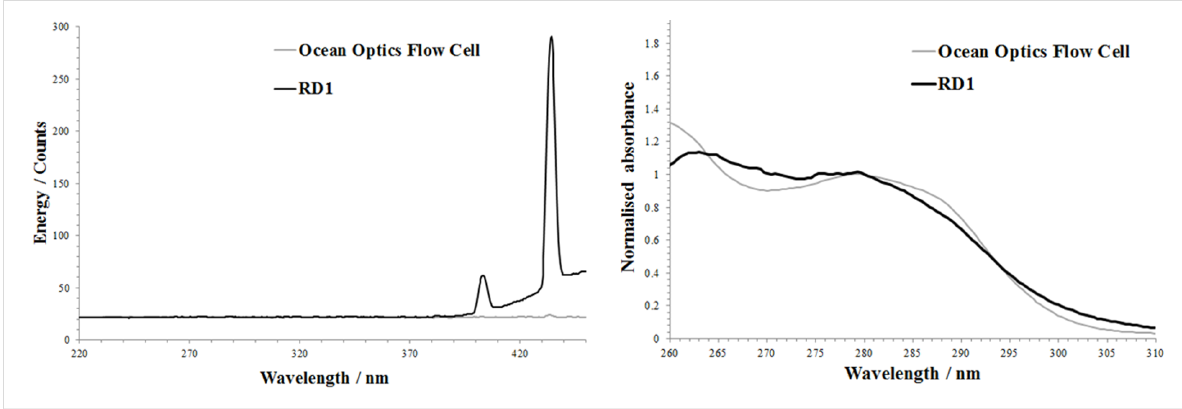
Figure 2: Energy versus wavelength spectra comparing the amount of stray light being picked up by the detector using both RD1 and a commercial flow cell (left), normalised absorption spectra of a benzaldehdye solution passing through both RD1 and a commercial flow cell (right).